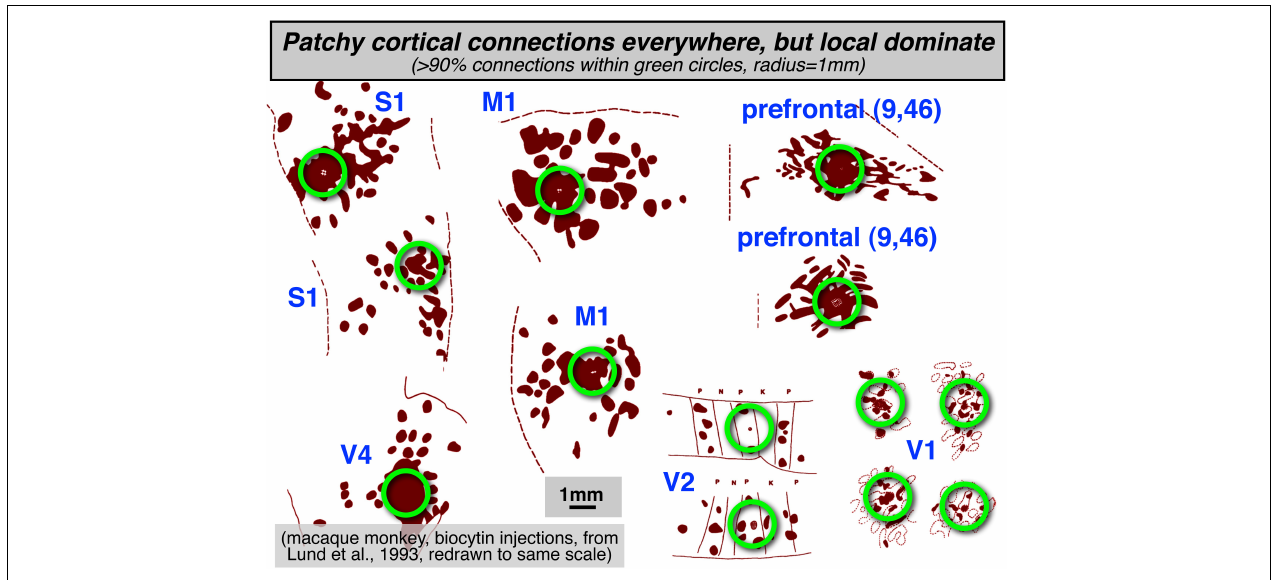
FIGURE 1 | Patchy local structures and connections are found everywhere in the cortex. However, the numerical majority of connections are made within a 1 mm radius (green circles).